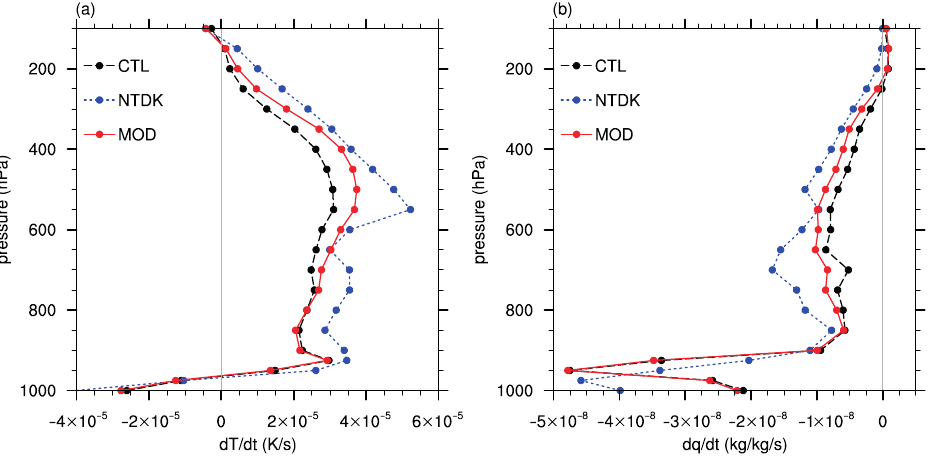
Figure 4. Vertical profiles of ( a ) the heating and ( b ) moistening tendencies averaged over the selected domain (100° E–160° W, 0–50° N) and over the period from 0000 UTC on 24 July to 0000 UTC on 25 July 2017 from the CTL (black dashed), NTDK (blue dotted), and MOD (red solid) experiments. Note that the tendencies from the GFS shallow convection scheme are included in the CTL and MOD